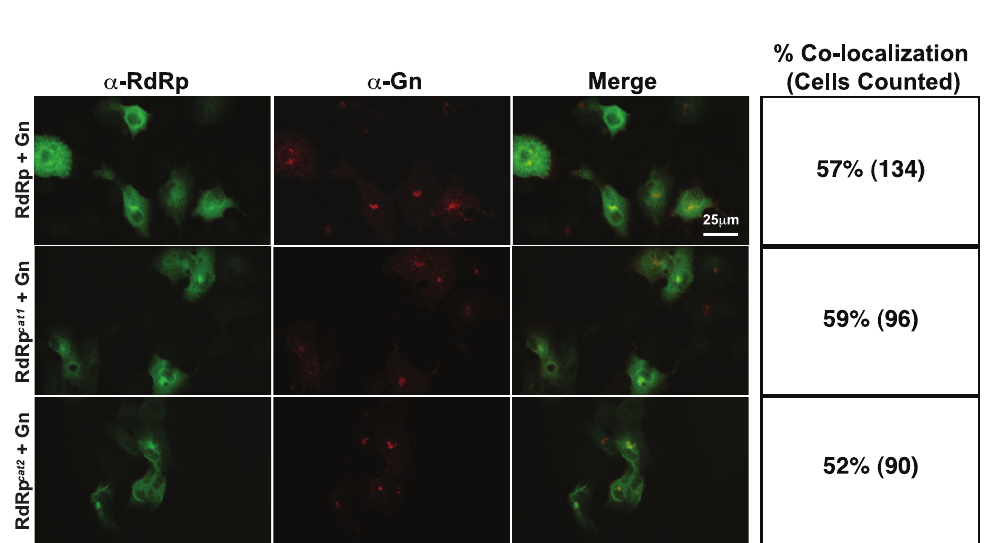
Figure 4. Packaged, catalytically active RdRp is necessary for an early event in the replicative cycle. A. BSR-T7/5 cells were transfected with genome and all of the structural proteins (WT), or one or more of the components was replaced with an equivalent amount of empty vector (- Gn/Gc and –RdRp) or with plasmids expressing mutant alleles of Gn or RdRp (GnK48 or pRdRp cat1 ). Transfected cells were analyzed for protein expression by immunoblot. RVF-VLPs were immune precipitated from the clarified media from transfected cells and analyzed by immunoblot. The numbers below the immunoblots indicate the ratio of glycoprotein to N signal. B. BSR-T7/5 cells were transfected with pGn and either pRdRp or RdRp catalytic domain mutants, pRdRp cat1 or pRdRp cat2 . Cells were incubated with anti-Gn (red channel) and anti-RdRp (green channel), and then analyzed by immunofluorescence microscopy. Percentage of cells displaying co-localization of RdRp alleles with Gn is indicated with the number of cells counted in parentheses. RLuc signal as compared to untransfected target cells (Table 1), indicating that the observed signal enhancement by wild-type RdRp is due to catalytic activity and not cooperativity. By were capable of infecting untransfected target cells and had RLuc contrast, RVF-VLPs packaging RdRp cat1 or RVF-VLPs lacking the RdRp (-RdRp) could not be complemented in trans with an active RdRp (Table 1). Wild-type RVF-VLPs were the only RVF-VLPs to generate a significant RLuc signal as compared to background (-Gn/-Gc) (Table 1). These results indicate that (Table 1). Expression of RdRp cat1 in target cells did not enhance catalytically active RdRp must be packaged in the RVF-VLP in